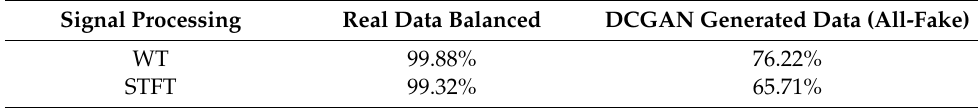
Table 8. Comparison of different signal processing.